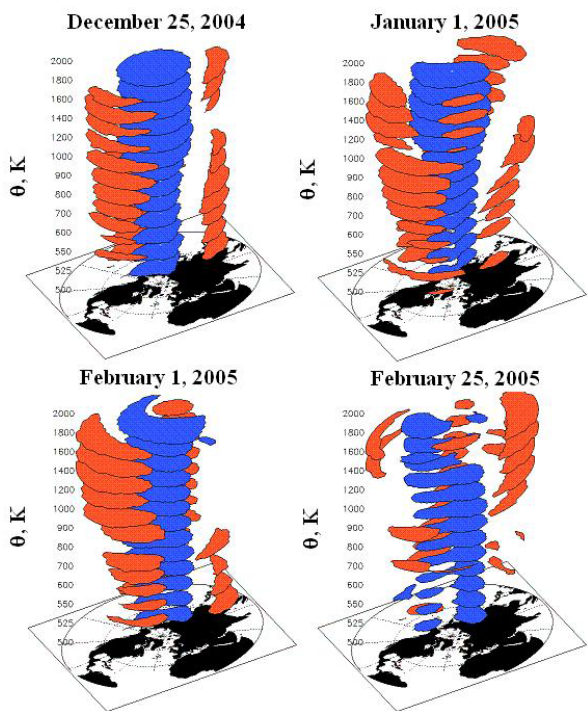
Fig. 4. Representation of the polar vortex (blue) and anticyclones (orange) from θ =500 to 2000K ( ∼ 20–50km) isentropic surface on 25 December 2004; 1 January, 1 February and 25 February